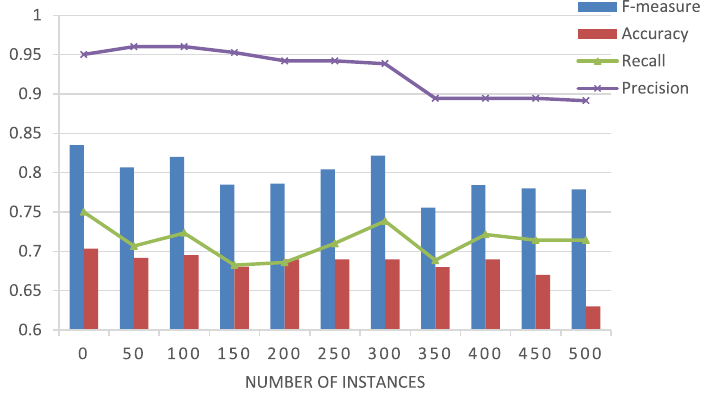
Fig. 7. HCR dataset: Evolution of F -measure, Accuracy, Recall, and Precision values according to the number of